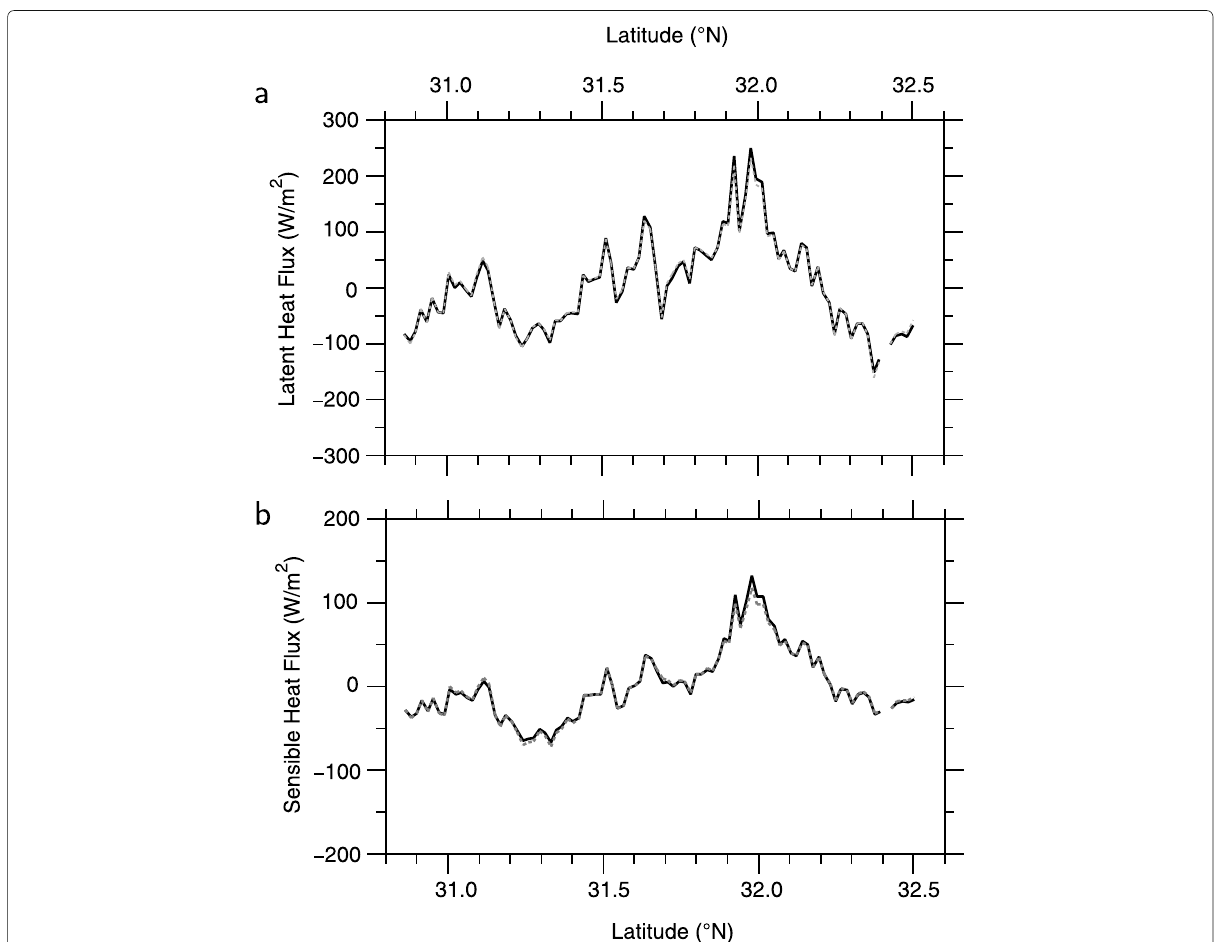
Fig. 9 Spatial variations in a latent and b sensible heat fluxes, (cid:2) F (black solid lines) and the sum of the contributions from variations in SST, air temperature, specific humidity, and wind speed, i.e., the right hand side of Eq. (1), (gray dotted lines) on track A